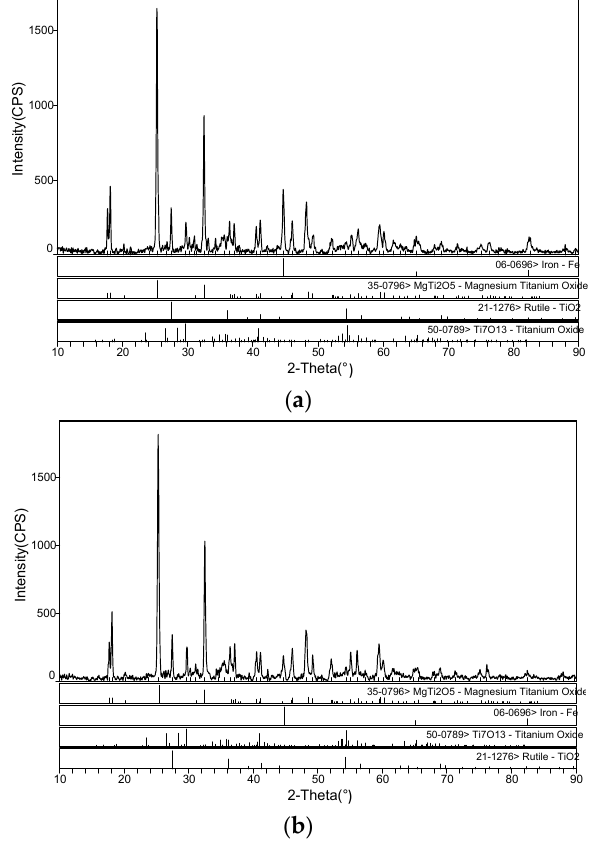
Figure 8. XRD pattern of non-magnetic product ( a ): the sample number is 2.5F; and ( b ): the sample number is 4.0F.